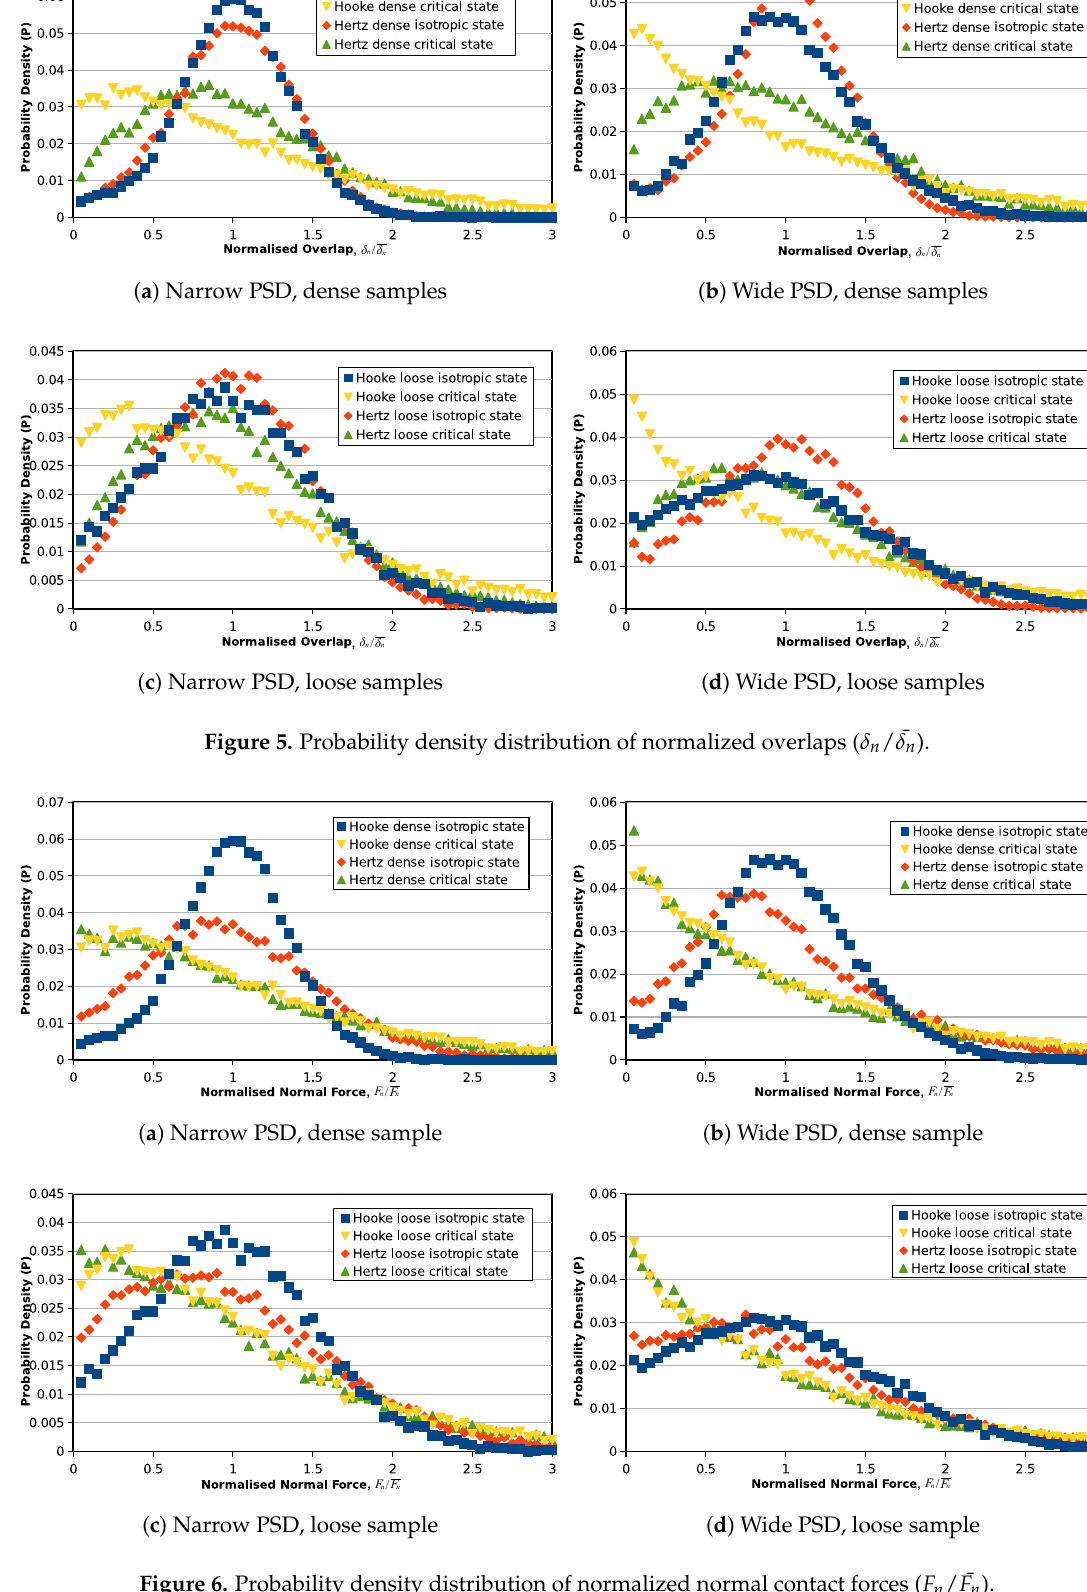
Figure 6. Probability density distribution of normalized normal contact forces ( F n / ¯ F n